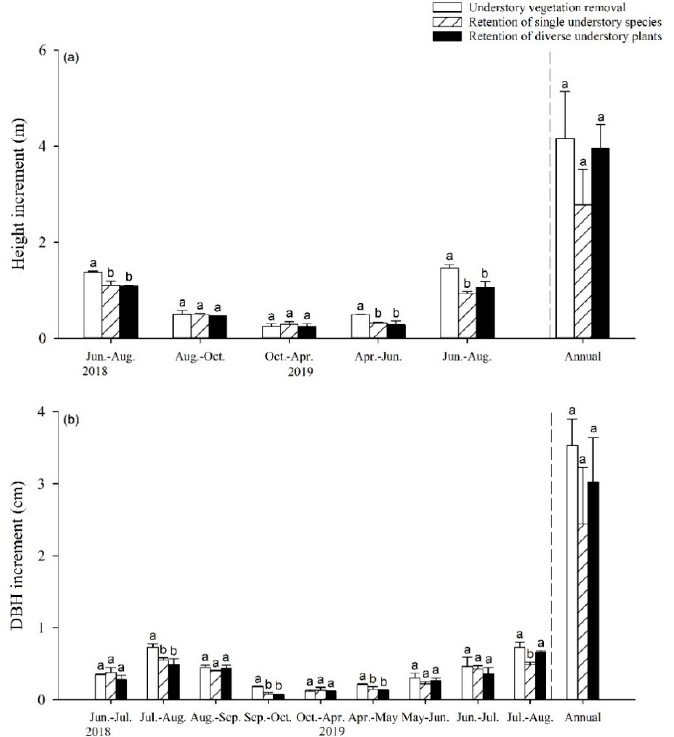
Figure 1. Increment of poplar tree height ( a ) and DBH ( b ) with increase in understory vegetation species richness. The annual increment was determined by summing the increments of poplar tree height and DBH from June 2018 to May 2019. Different letters indicate significant differences between treatments at p < 0.05.